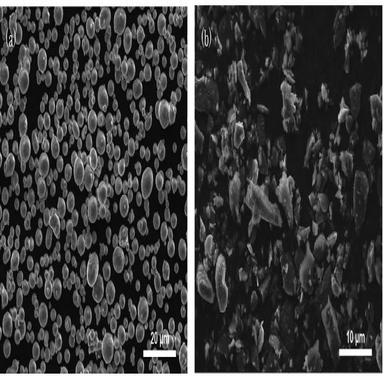
SEM micrographs of starting materials; (a) Al powder, (b) B4C powder.